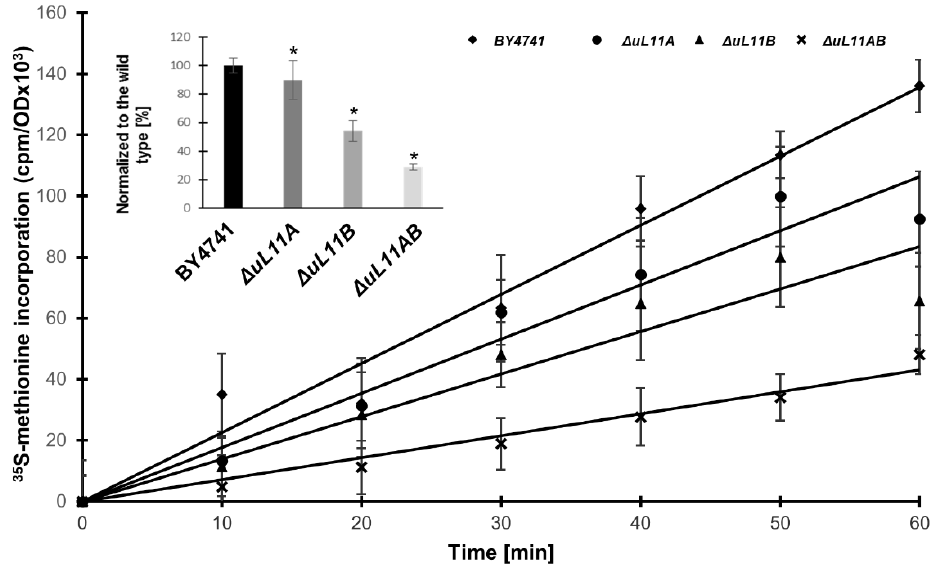
Figure 3. Impact of uL11 gene deletion on translational efficiency in vivo. Translational fitness determined from the time course of 35 S-methionine incorporation. The inset shows the translational efficiency normalized to the wild type strain. Error bars represent standard deviations obtained from three independent experiments. Statistical significance was assessed using Student’s test (* p < 0.01).